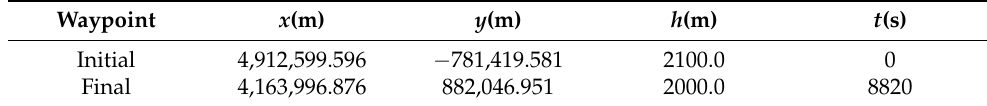
Table 5. Initial and final waypoints of the reference commercial trajectory.